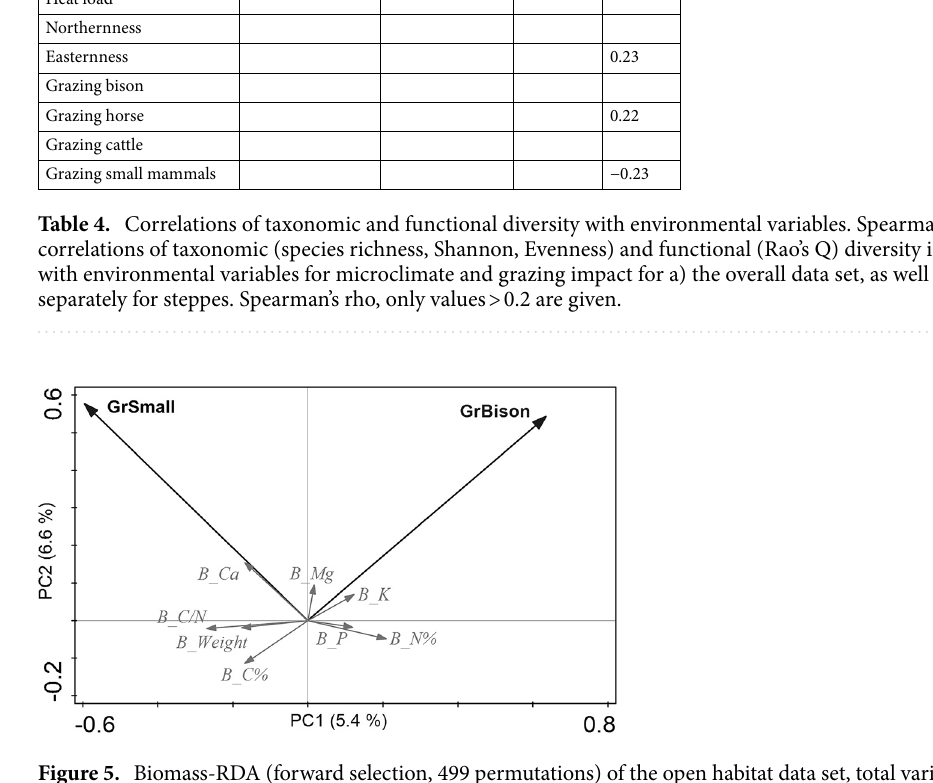
Figure 5. Biomass-RDA (forward selection, 499 permutations) of the open habitat data set, total variance: 652, explained variance: 6.6%, Eigenvalues: Axis1: 0.03, Axis2: 0.01; %explained variation: Axis1: 5.4, Axis2: 6.6; only significant grazing variables (bison—GrBison); small mammals—GrSmall) are